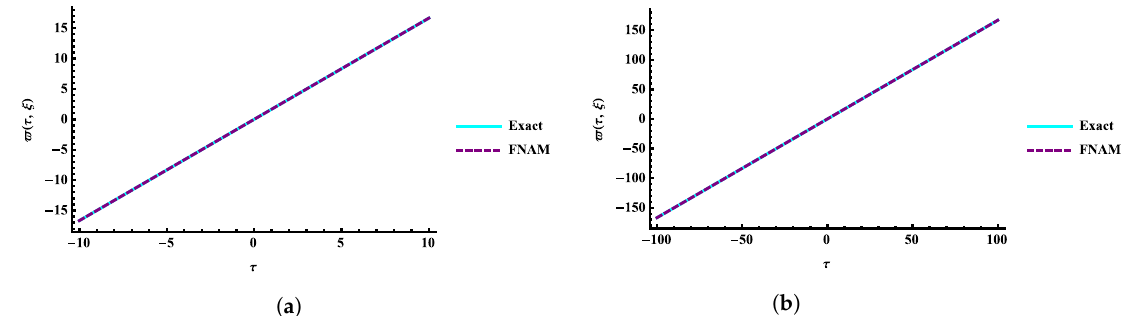
Figure 11. Comparison 2D plots of numerical and exact solutions by using FNAM verses ( a ) τ ∈ [ − 10,10 ] and ( b ) τ ∈ [ − 100,100 ] at time ξ = 0.2 and a = c = 1 for Example